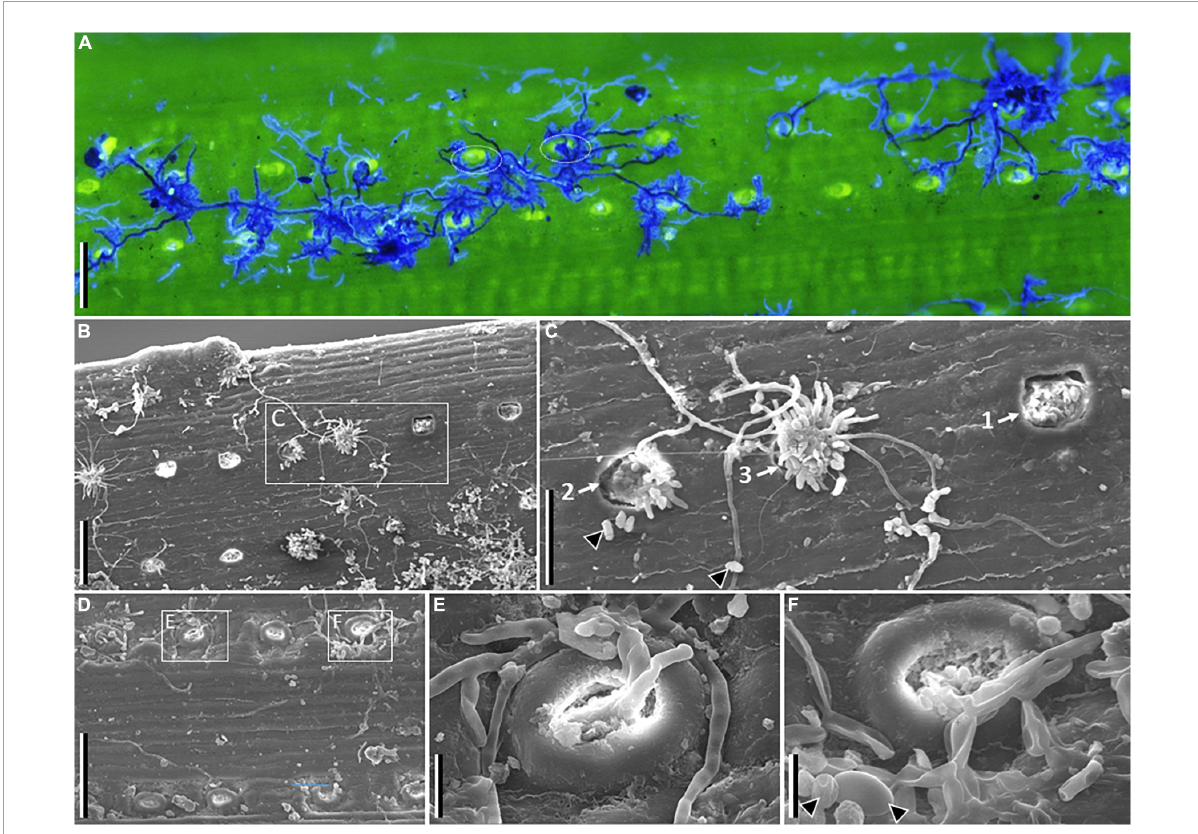
FIGURE2 Microscopy images of symptomatic needles of Pinus sylvestris tested positive for Sphaeropsis sapinea . Fluorescence (A) and scanning electron (B–F) images. (A) Shows fungal hyphae in dark and light blue agglomerating around or growing between stomata. (B) Shows stomata at various stages of infection, and (C) developmental sequence of pycnidia emergence and hyphal growth (from 1 to 3). (D) Shows infected stomata, with details showing fungal hyphae emerging (E) or entering (F) stomata (arrowheads point to conidia in F ). Scale bars: A, B, D = 100 µ m; C = 50 µ m; E, F = 10 µ